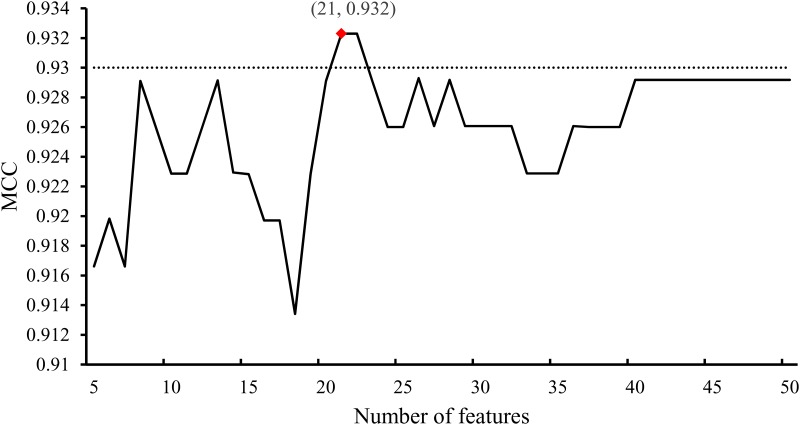
A part of the IFS curve shown in Fig 2.